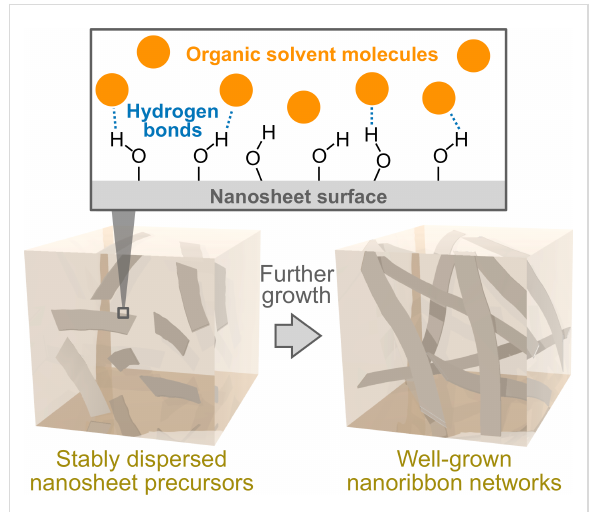
Figure 10: Schematic illustration of the proposed mechanism for dispersion stabilization of the nanosheet precursors via solvation with the organic